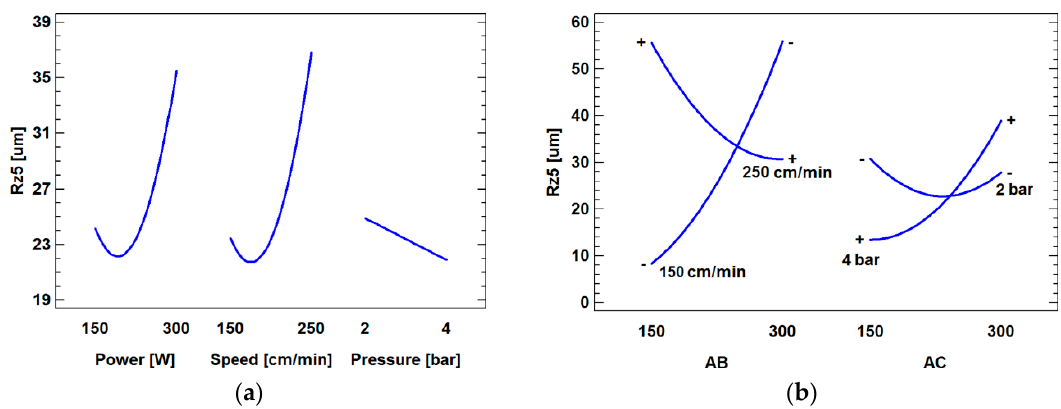
Figure 7. ( a ) Main effects and ( b ) interaction plots of mean height of the surface profile. A: laser power; B: cutting speed; C: oxygen pressure. Polynomial trendlines have been used to fit perpendicularity tolerance data.